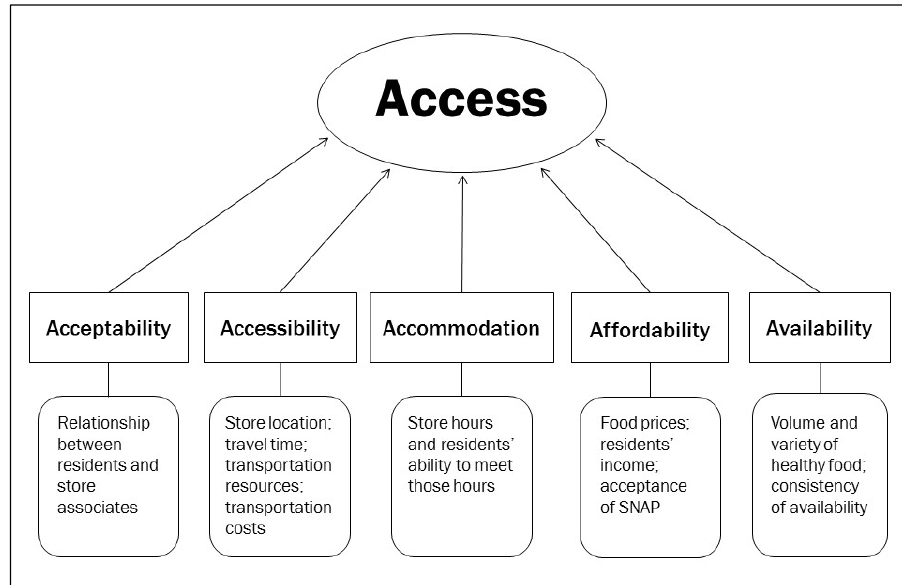
Figure 1. The Five Dimensions of